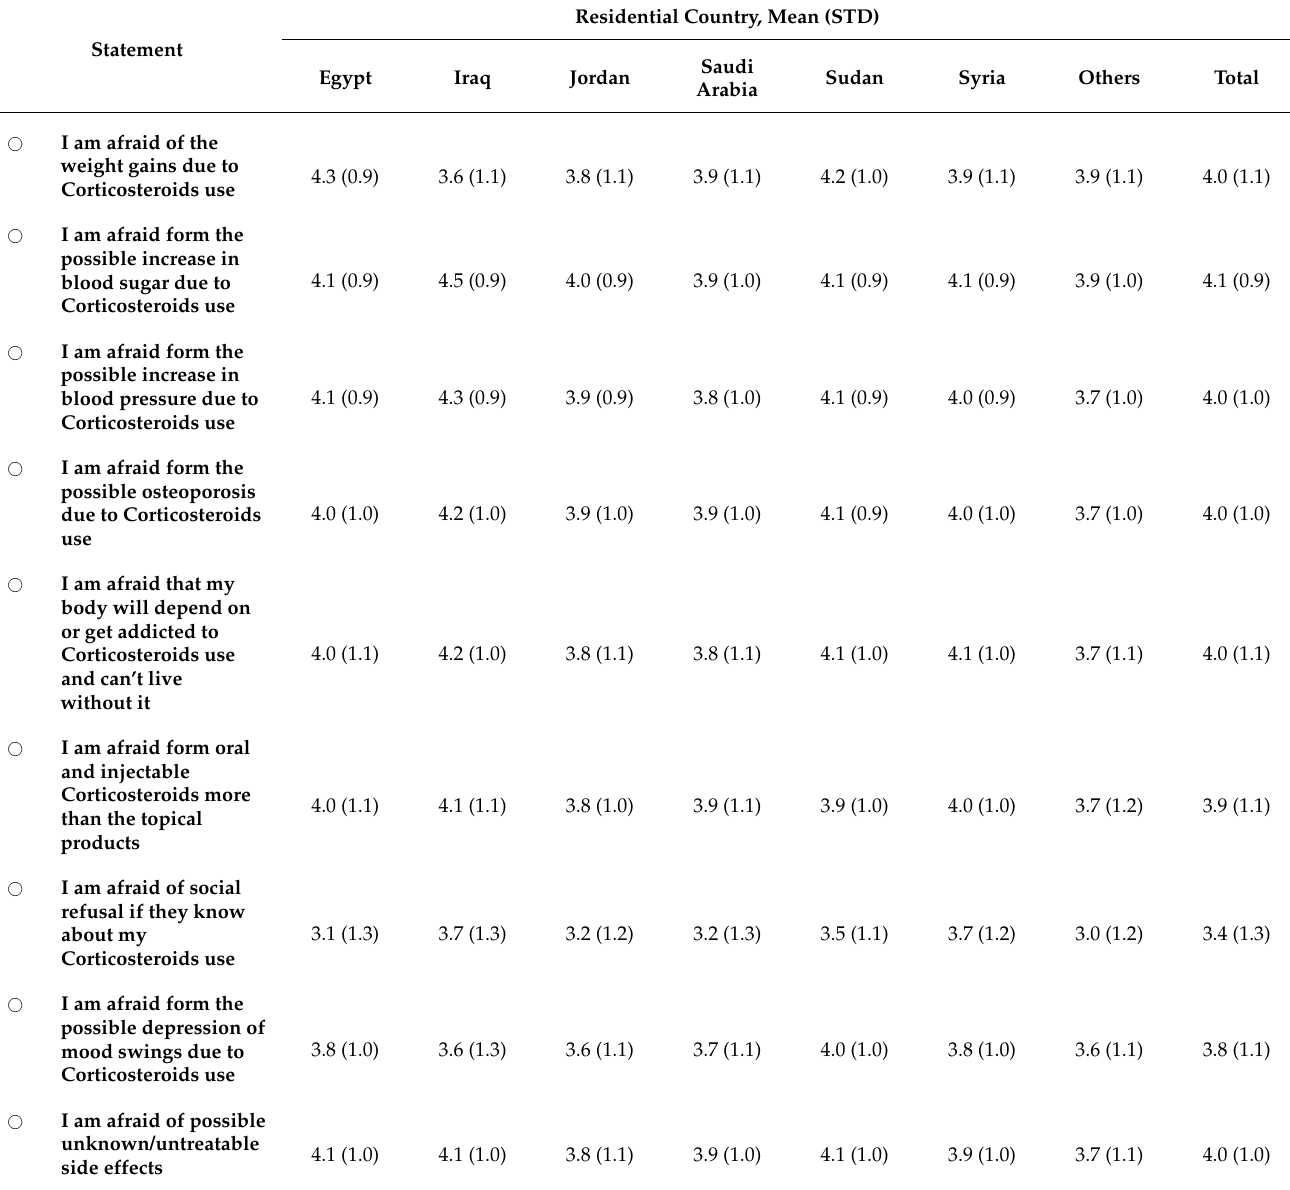
Table 5. The mean scores of corticophobia among the study participants from different